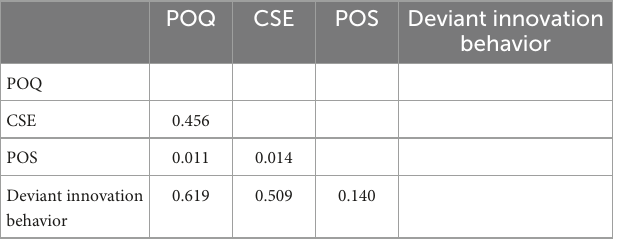
TABLE 2 Discriminant validity heterotrait-monotrait ratio of correlations (HTMT). POQ CSE POS Deviant innovation behavior